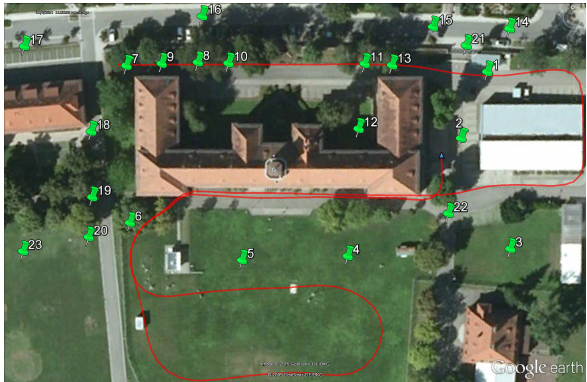
Figure 3. Path driven by the sensor vehicle (MLS data) during the data acquisition and 23 positions of TLS scanner (Image data: Google Earth, Image c (cid:13) 2015 GeoBasis-DE/BKG).